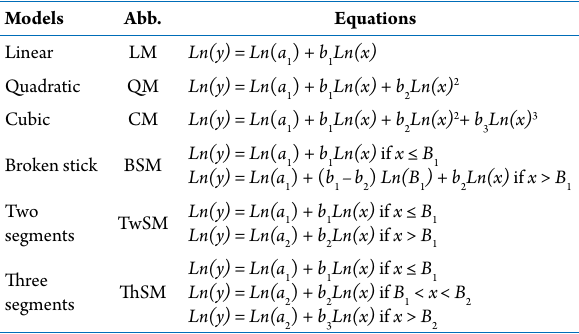
Chart 1. Equations and abbreviations from candidate models used